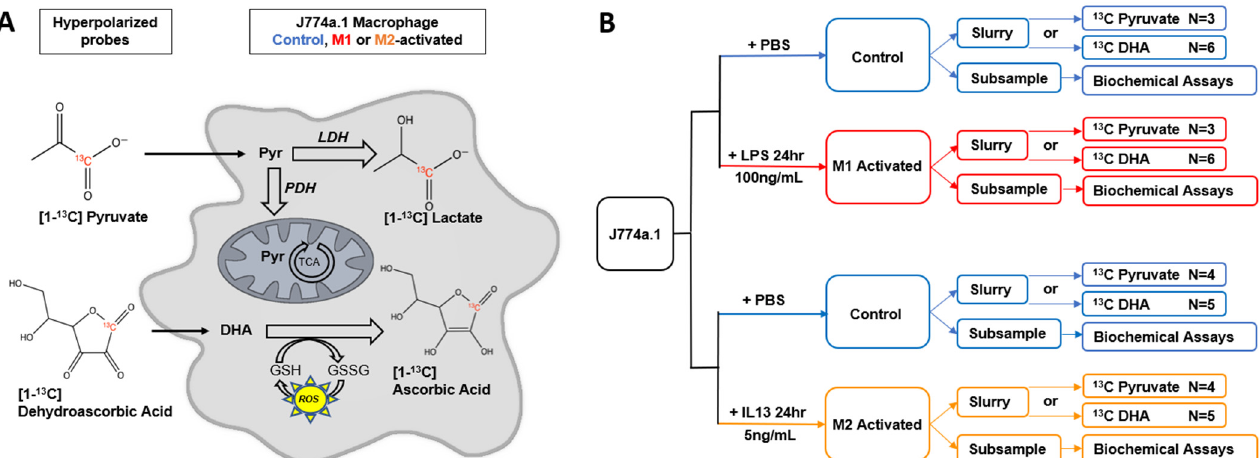
Figure 1. Overall design. ( A ) Schematic of hyperpolarized 13 C probes and their metabolic fates in J774a.1 macrophages. LDH = lactate dehydrogenase; PDH = pyruvate dehydrogenase; TCA = tricarboxylic acid cycle; GSH = glutathione; GSSG = glutathione disulfide; ROS = reactive oxygen species. ( B ) Overall experimental design of the study. Activation was achieved with either lipopolysaccharide (LPS, M1 activation) or interleukin-13 (IL-13, M2 activation). Control and M1/M2 activated samples were paired for HP studies and for spectrophotometric assays. N = number of repeats.